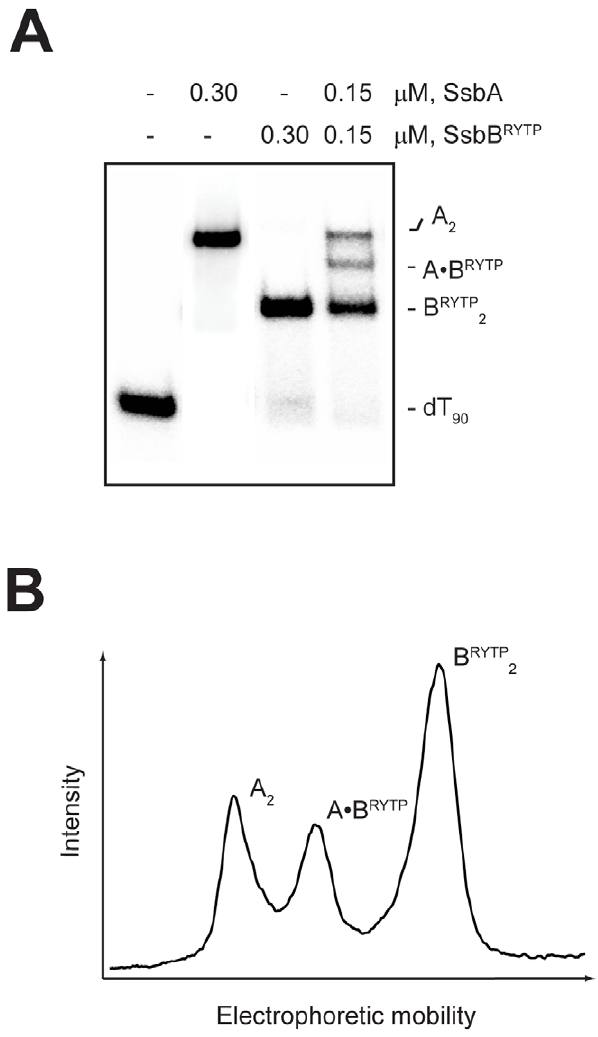
Figure 8. Binding of SsbA and SsbA/B proteins to dT 90 . The reaction solutions contained 25 mM Tris acetate (pH 7.5), 5 m M dT 90 (total nucleotide concentration), and the indicated concentrations of SsbA and SsbA/B protein (tetramer concentrations). A, The reactions were analyzed by polyacrylamide gel electrophoresis using a gel running buffer consisting of Tris acetate (pH 7.5). The bands corresponding to the unbound dT 90 oligomer, and the A 2 , (A/B) 2 , and A ? A/B complexes, were visualized by phosphorimaging. B, The lane for the reaction that contained 0.15 m M SsbA and 0.10 m M SsbA/B was scanned to show the relative intensities of the bands for the indicated complexes.